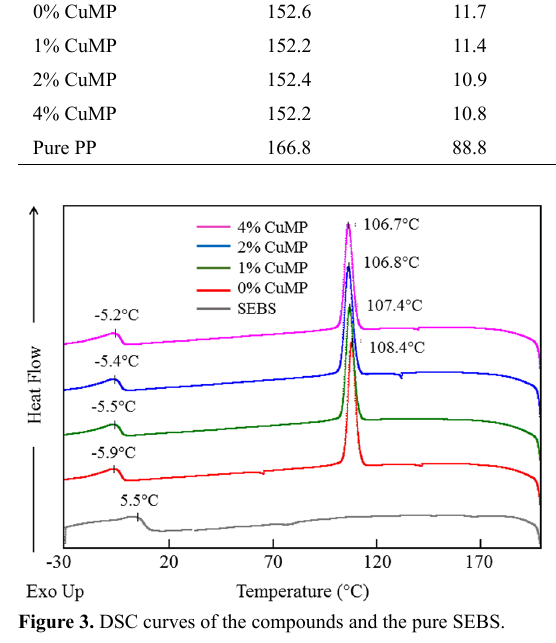
Table 3. Melting (Tm) and Crystallization (Tc) Temperatures, Fusion, and Crystallization Enthalpy (∆Hf) and degree of crystallinity of PP phase (XPP) obtained by DSC. Sample